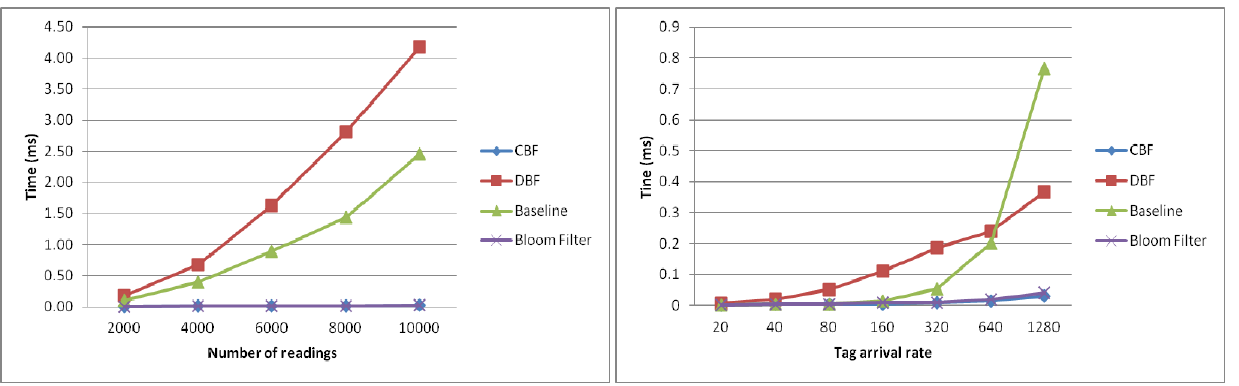
Figure 7. Time execution comparison to filter duplicate